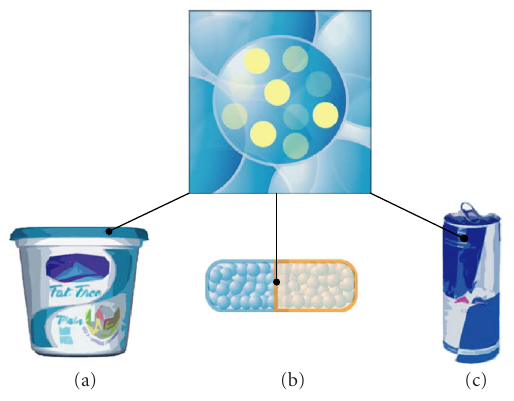
Figure 5. Artificial cells for bacterial cell therapy can be stored and delivered in several ways. (a) Microencapsulated bacterial cells can be incorporated into foodstu ff s such as fermented milk products (yogurt and ice cream). (b) Microcapsules can be de- hydrated and incorporated into capsules or into pill form with a shelf-life of up to two years. (c) Microcapsules can be stored for months at low temperature in minimal solution and can be administered in drink